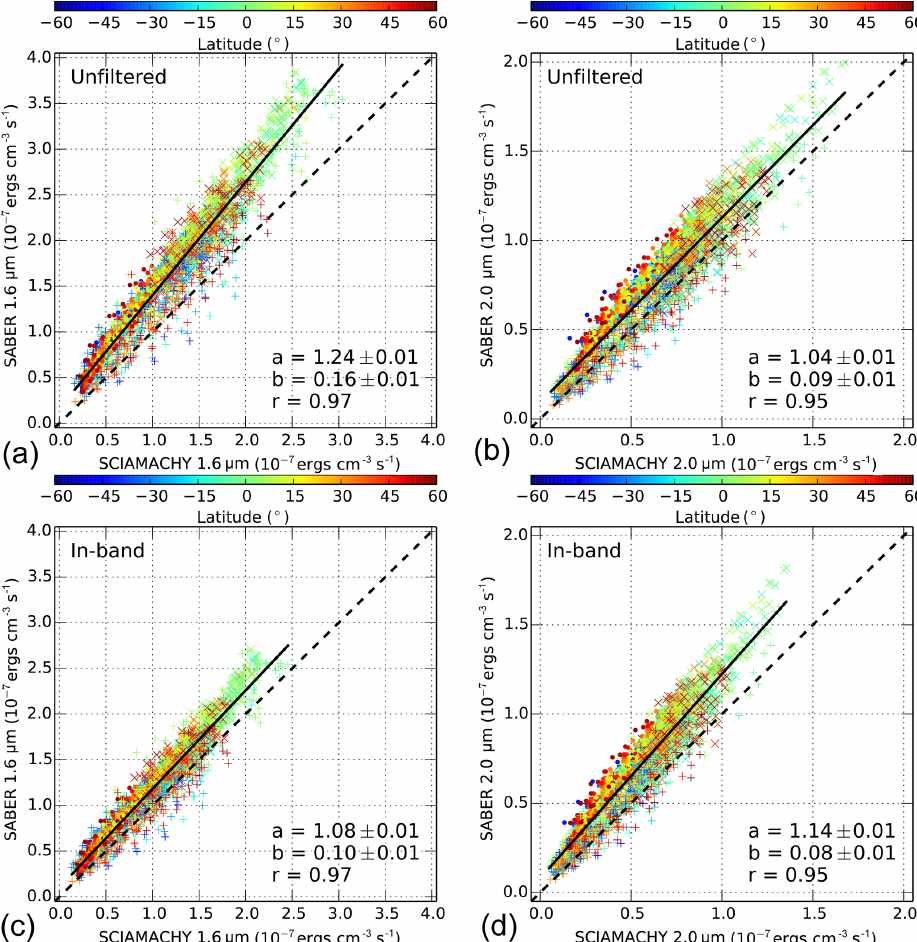
Figure 6. Scatter plots of SABER 1.6µm (a, c) and 2.0µm (b, d) volume emission rates vs. the corresponding simulations using SCIA- MACHY data for the year 2007. The color bar shows the latitude. The plus marker indicates the data at 80–85km, the x marker represents the data at 86–90km, and the point marker shows the data at 91–95km. The solid line shows the linear fit to the data. a and b represent the slope and y intercept of the fitting line, respectively. r represents the correlation coefficient of the